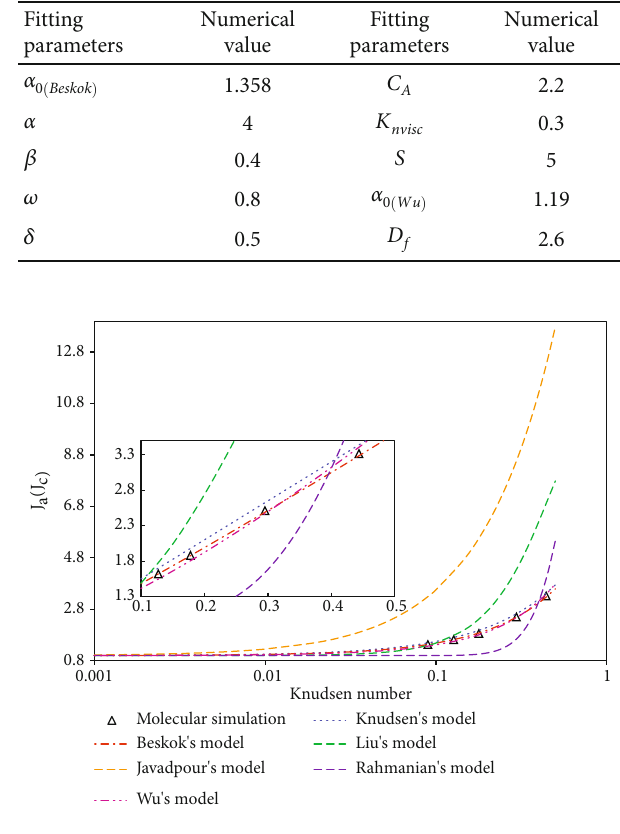
Figure 2: Comparison of existing models and molecular simulation results under low Kn